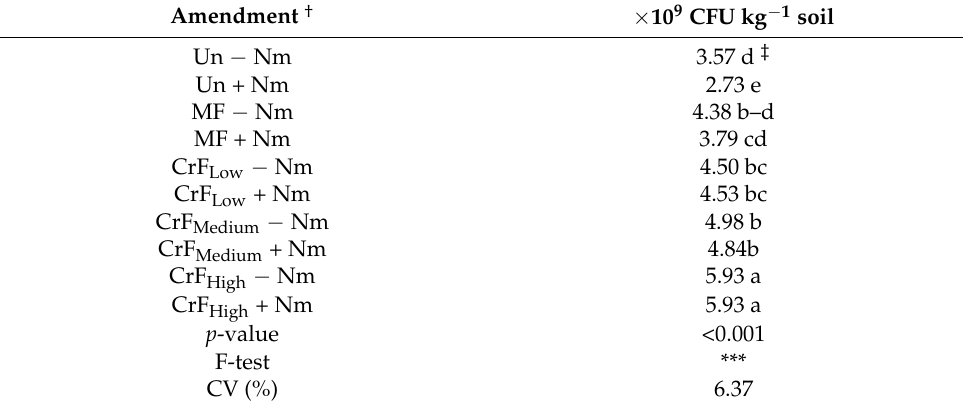
Table 6. Soil microbial number indicated by the colony-forming unit (CFU) as affected by different rates of cricket frass and neem seed